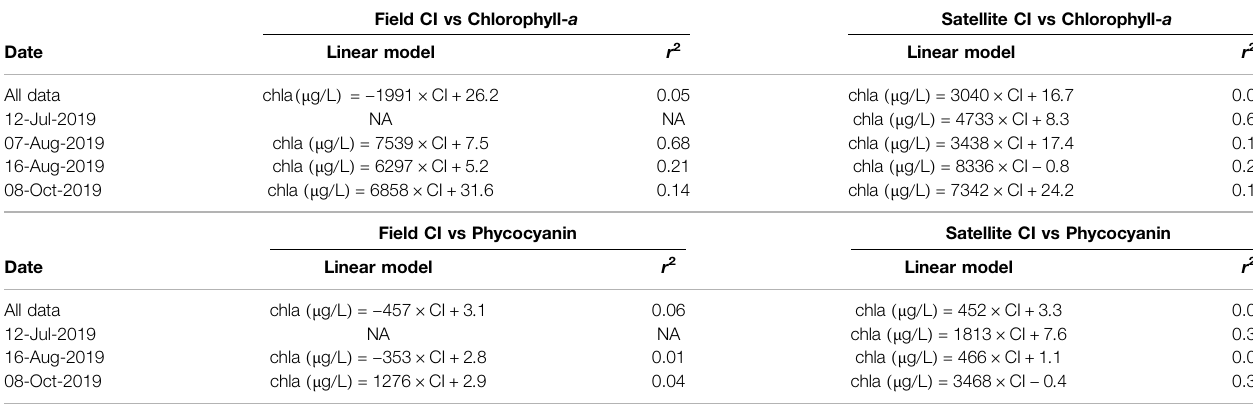
TABLE 3 | Linear model parameters as well as the model performances of results of least-squares linear regression analysis relating the calculated CI to observed chlorophyll-a and phycocyanin concentrations. Only the linear models Field CI vs Chlorophyll- a (07-Aug-2019), Satellite CI vs Chlorophyll- a (All Data, 12-Jul-2019, and 16-Aug-2019), and Phycocyanin vs Satellite CI (12-Jul-2019 and 8-Oct-2019) are signi fi cant (corrected p -value < 0.05, where p -value is corrected using Benjamini and Hochberg False Discovery Rate procedure). The signi fi cant models have positive linear slopes. The signi fi cant models have moderately low to moderately high